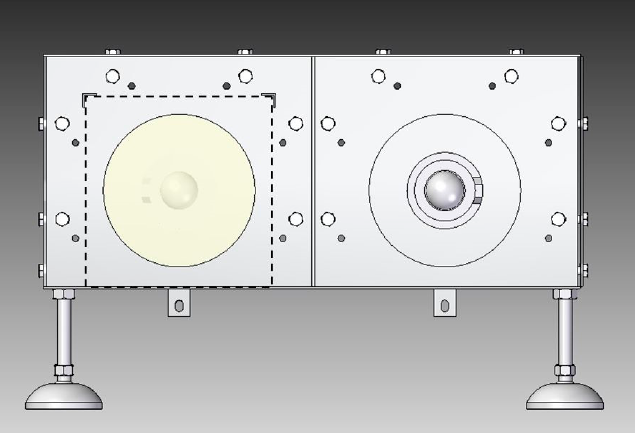
Figure 4. PCM glazing sample holder with built-in sensors. Left cell covered with PCM window, right cell as a reference.